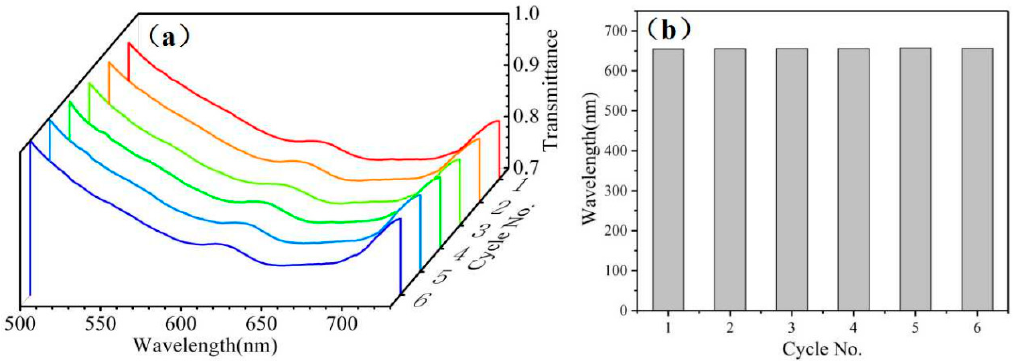
Figure 6. ( a ) D-type fiber sensor normalizes six cycles of transmission spectrum in 1.355 RI alcohol solution. ( b ) Histogram of the wavelength corresponding to the lowest RI of the six normalized transmission spectra.